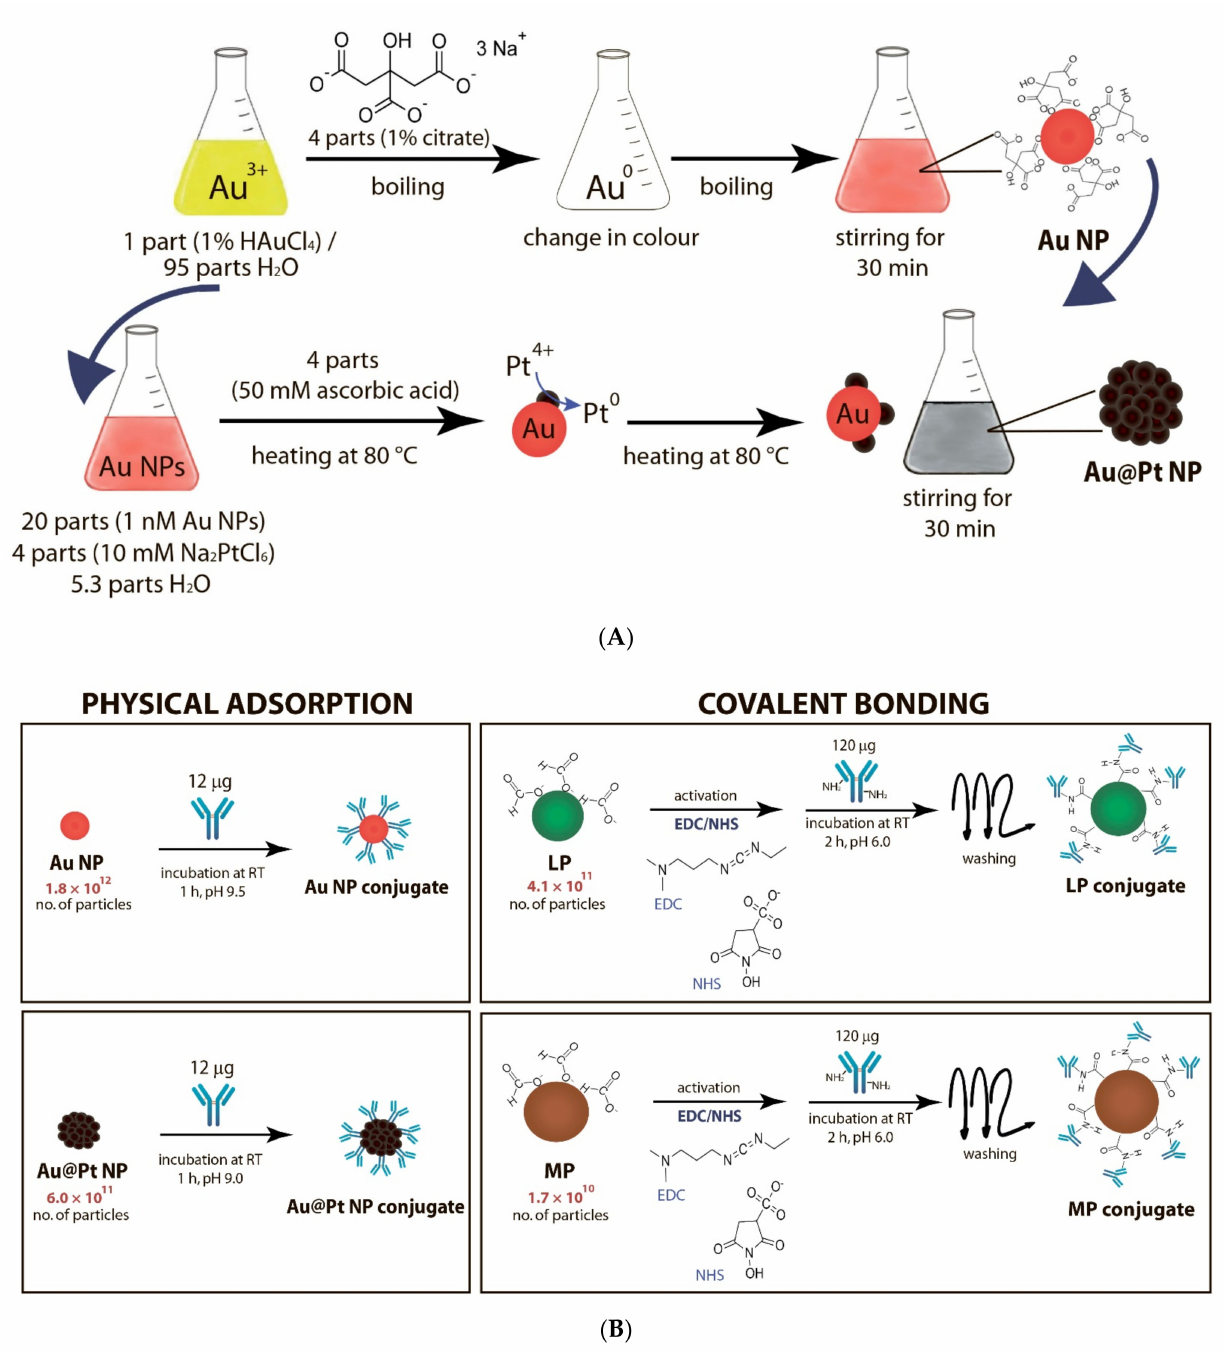
Figure 1. Syntheses of nanoparticles ( A ) and their conjugates with antibodies ( B ). For LPs, a mini centrifuge was used, while for MPs, a magnetic rack was used to remove/separate